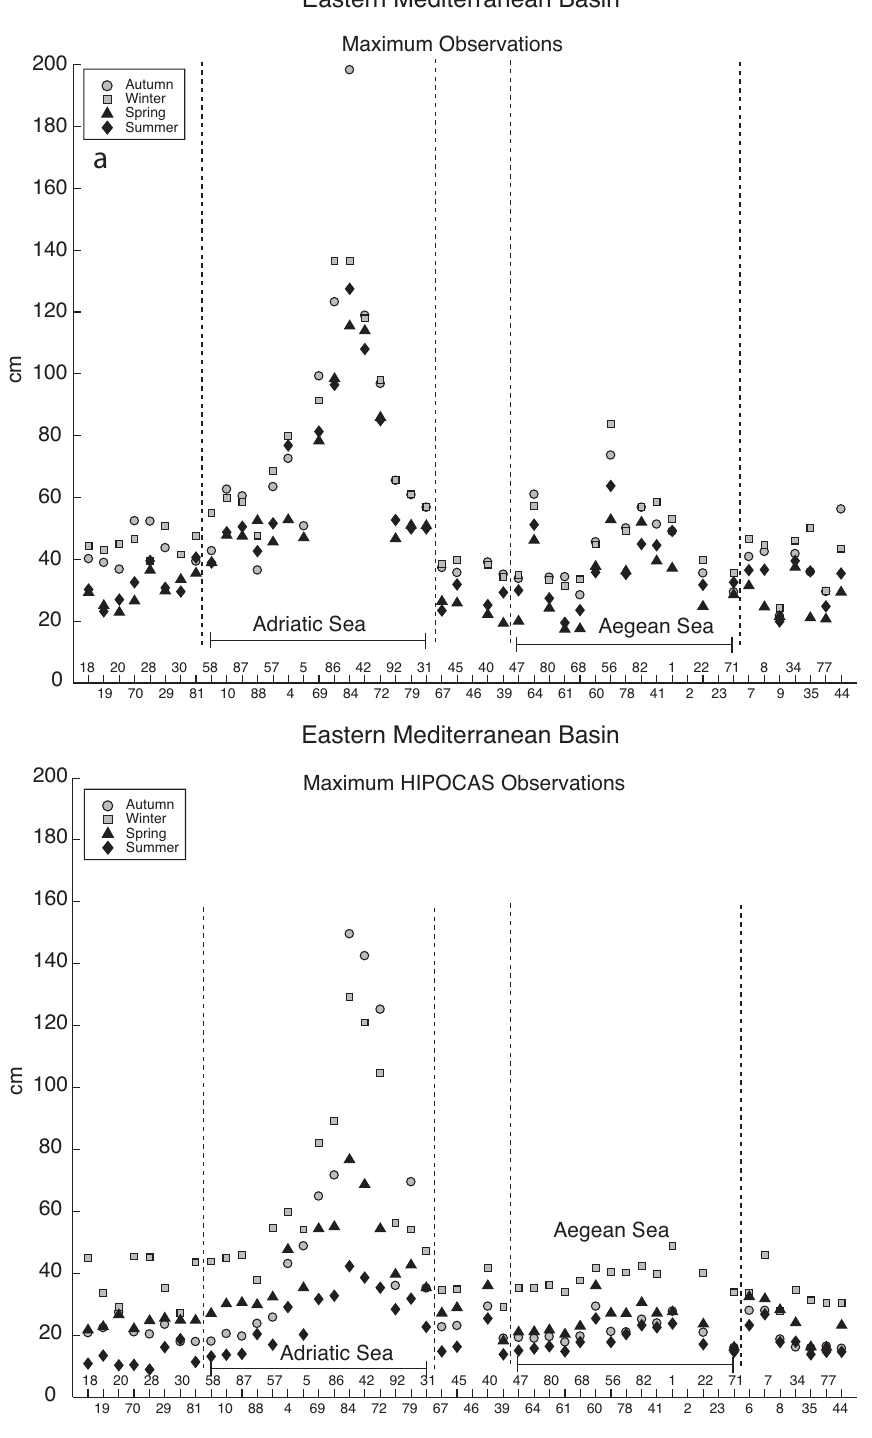
Figure 5. As Figure 3 for the eastern Mediterranean tide-gauges. Fig. 5. As Fig. 3 for the eastern Mediterranean tide-gauges. Fig. 5. As Fig. 3 for the eastern Mediterranean tide-gauges. The trends in the 99.9% percentile of the observed val- est for winter. There is no consistency in the trends estimated ues are mostly positive (Table 2). In the Atlantic coasts, the for the stations in the western Mediterranean (Alicante and strongest positive trends are found for autumn and the small- Ceuta) but the highest trend values are those of summer. In